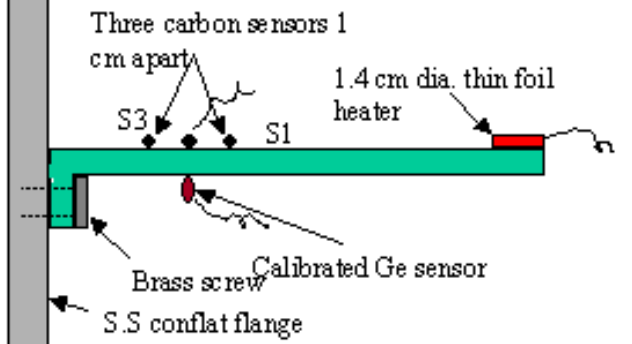
FIG. 5. (Color) Flat plate experimental setup. The Nb sample of size 11 (cid:5) 1 : 4 (cid:5) 0 : 3 cm has a germanium sensor on one side and three carbon sensors on the other, for in situ calibrations. The drawing is not to